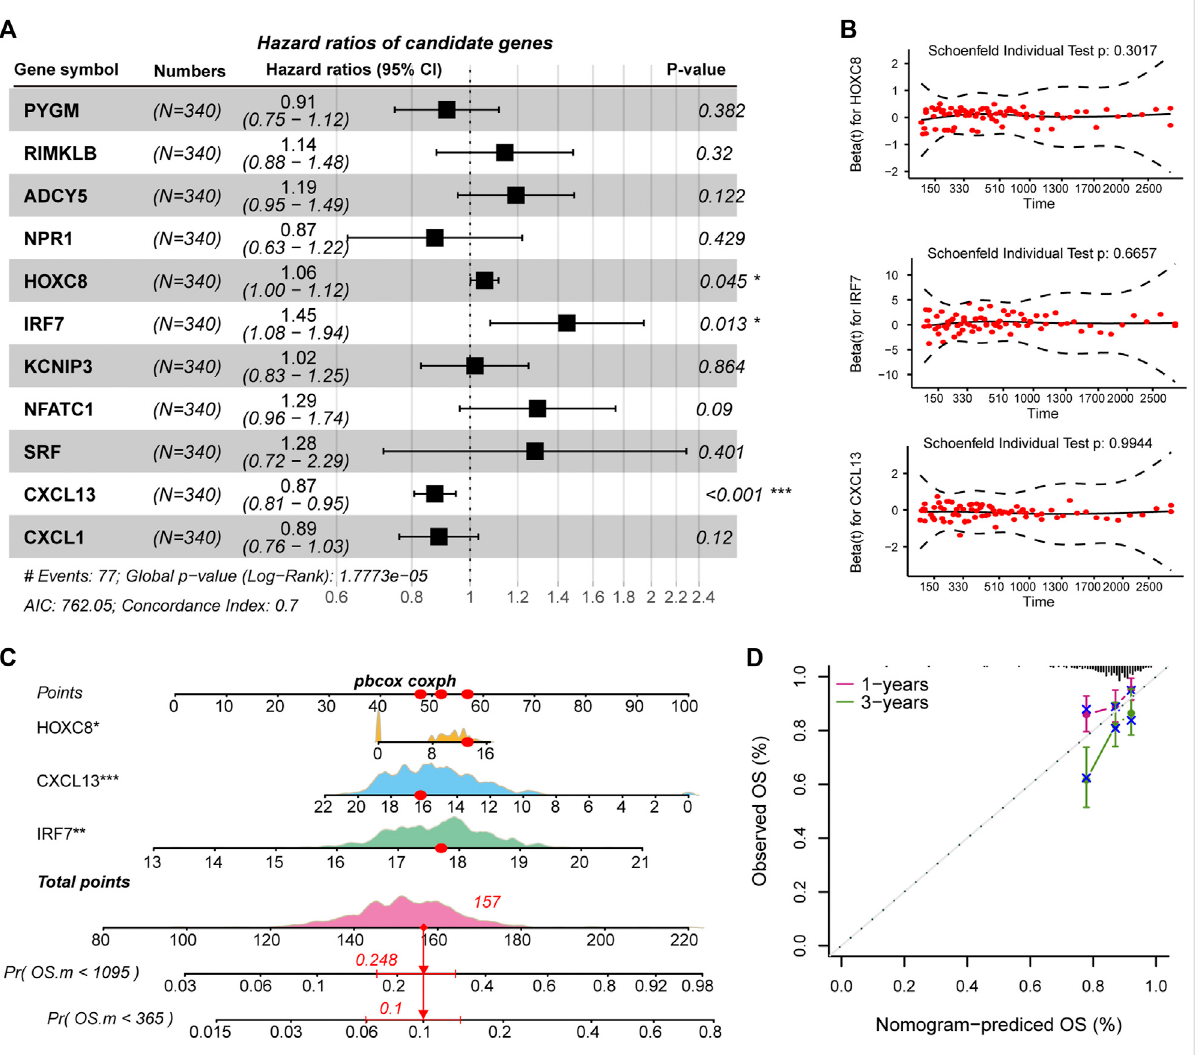
FIGURE 4 Identi fi cation of prognostic related genes in COAD. (A) Forest plots for multivariate Cox risk regression models. (B) PH hypothesis test of HOXC8,IRF7, and CXCL13. x-axisrepresentssurvivaltime,andy-axisrepresentsSchoenfeldresiduals. (C) Thenomogramshowsthepredictionof1- year and 3-years survival risk for patients of COAD. (D) Calibration curve of